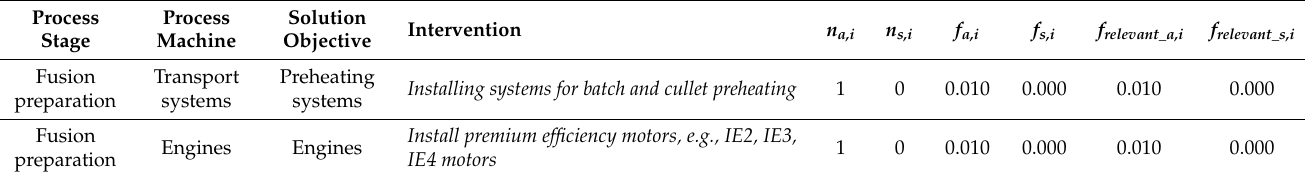
Table 3. Results of Italian glass-production